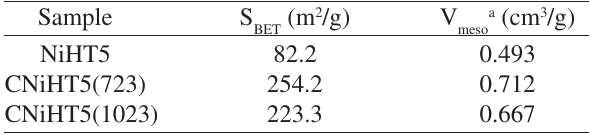
Table 2 . Textural characteristics of HT5 as-synthesized and cal- cined at different temperatures.